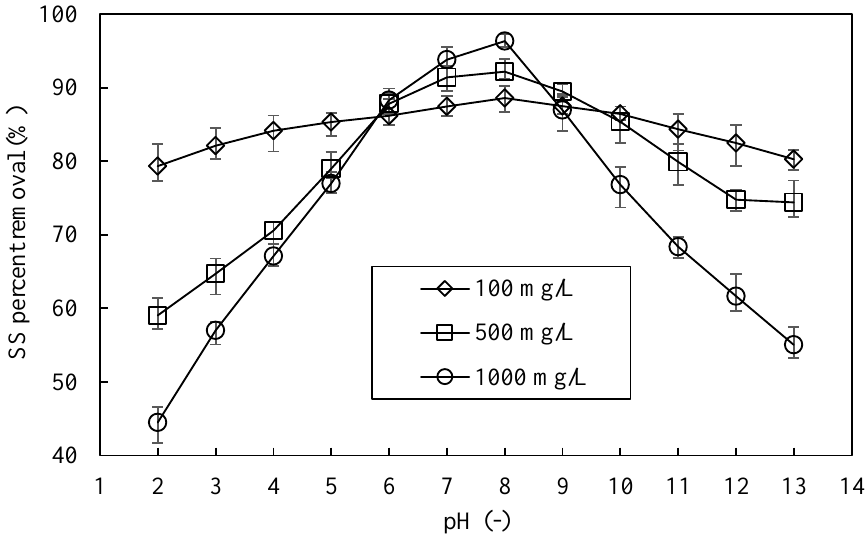
Figure 3. Influence of pH on the percent removal of SS in kaolin suspension samples with different initial concentrations. The error bars represent range of the observed values.